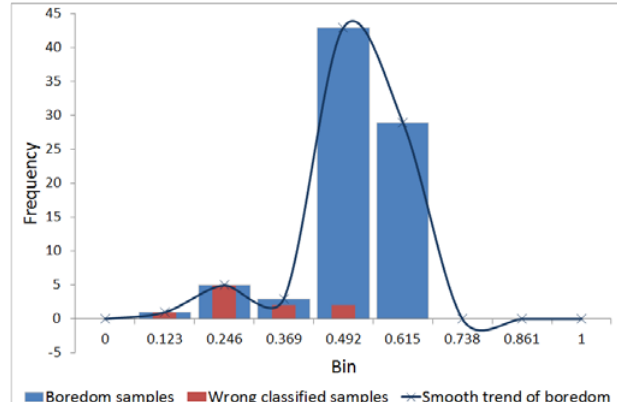
Further, when Boredom and Not Boredom samples are put together in the same dataset, and the measurements are plotted in an overlapping histogram, the Not Boredom samples are concentrated into the lowest bins. For these samples with lower Boredom values other emotions scored Figure 2. Example of SVM output for one voice better, reaching high values, which is reasonable and sample convey Anger. expected. Figure 4 shows both Boredom samples (in blue) and all samples (Boredom and Not Boredom; in grey) in order to compare the patterns.